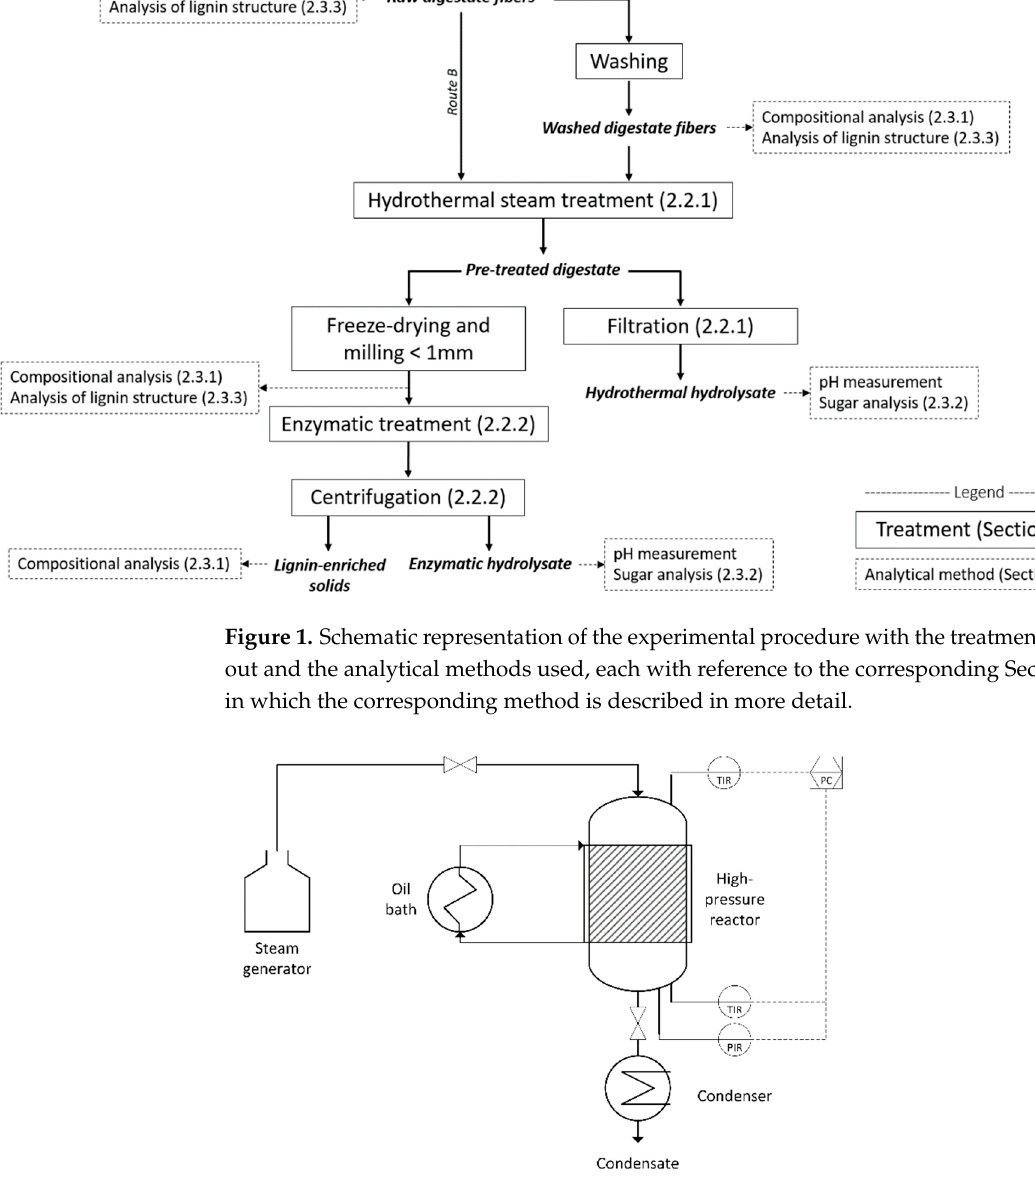
Figure 2. Schematic drawing of the reactor system for hydrothermal steam